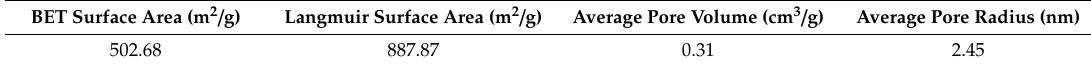
Table 2. Surface area, pore volume and radius of the fresh Fe-Ni /